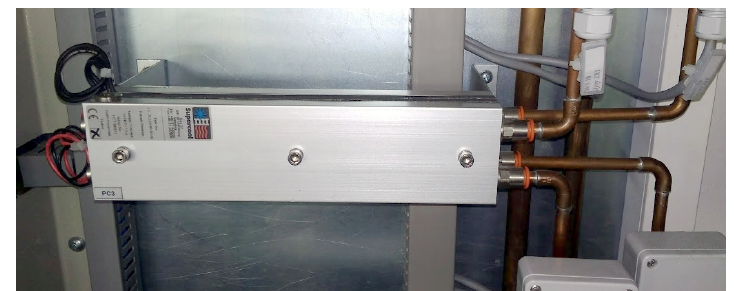
Figure 4. TEC assembly type